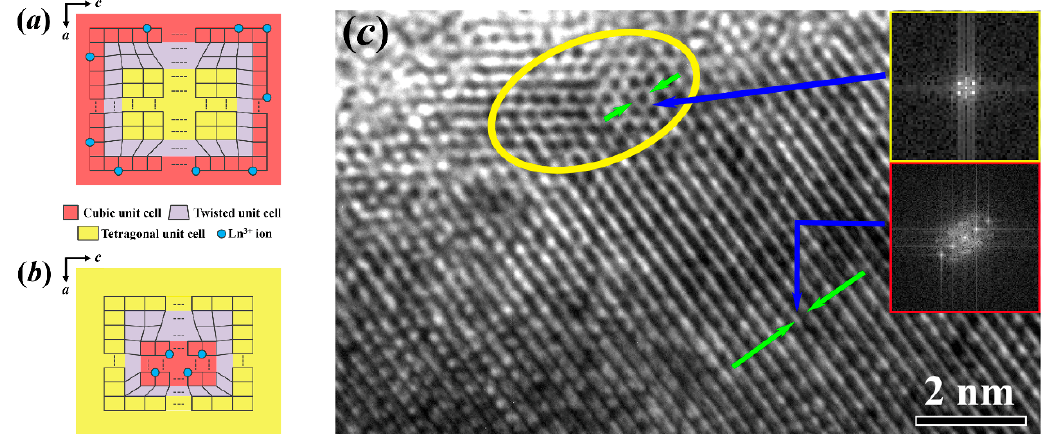
Figure 6. Schematic diagram for two kinds of unit cell arrangements of Ln doped ABO 3 in a region without considering the boundary of a crystal: ( a ) tetragonal region surrounded by cubic boundary and ( b ) cubic region surrounded by tetragonal boundary. Ln 3+ ions tend to be randomly distributed around the cubic unit cell. ( c ) The TEM image of 5.55%Nd-PMNT37 crystals. The upper right corner is the FFT pattern in small region and below is the FFT pattern in large area.